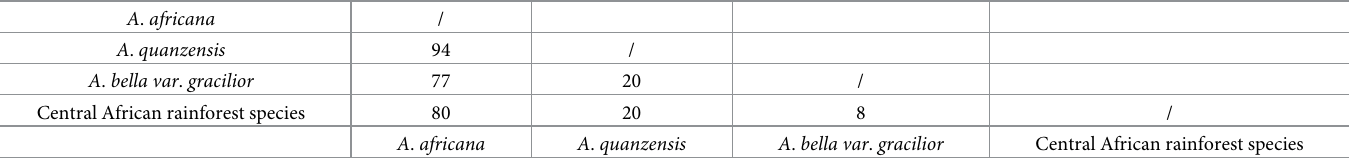
Table 2. SNP variation in plastid CDS regions among Afzelia species. “Central African rainforest species” indicates A . bella var . bella , A . bipindensis and A . pachyloba